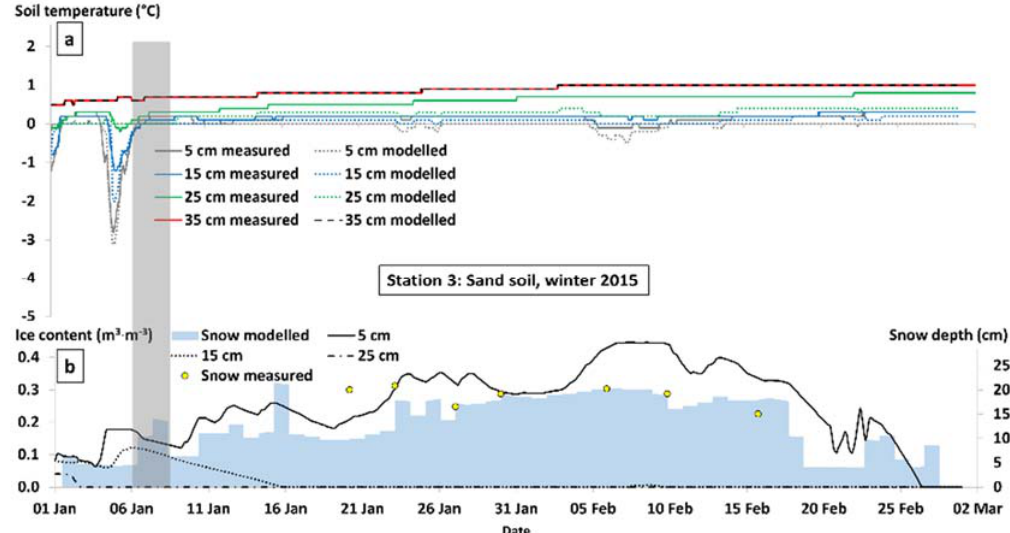
Figure 10. Diagram of ( a ) modelled and measured soil temperature at four depths (5, 15, 25 and 35 cm) in the sand soil (at Station 3) during winter 2015; diagram of ( b ) measured and modelled snow depths at Station 3 and modelled ice content at four depths in the sand soil (was zero at 35 cm). The duration of the rain event of interest is marked with a grey band.